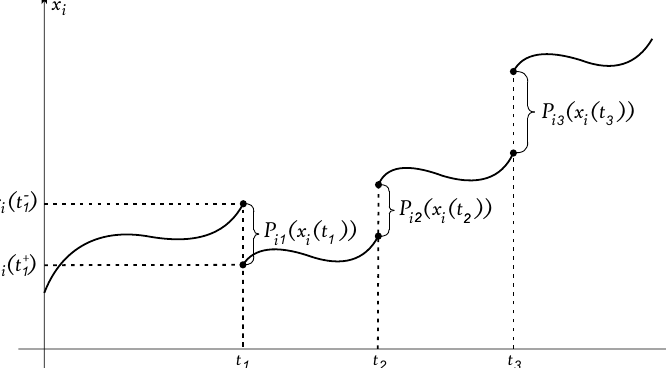
Figure 1. The trajectory of a mature state x i ( t ) of the impulsive control model (9). The control model (9) generalizes many existing type (3) DCCN models to the impulsive case. It can be applied to impulsively control the behavior of the neurons in type (3)